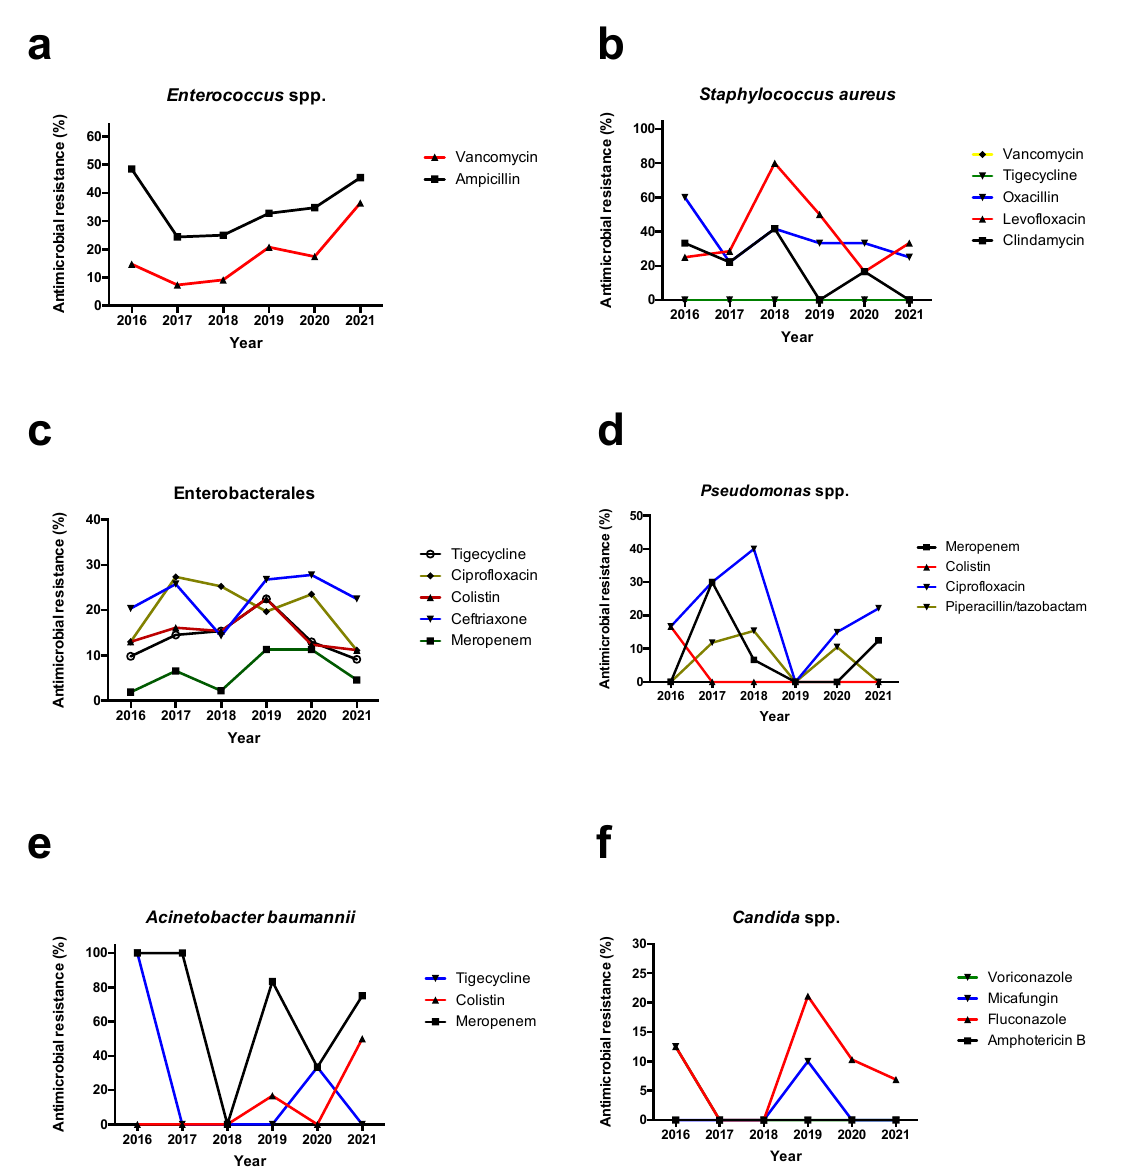
Figure 2. Antimicrobial resistance of isolated microorganisms in regard to the year during the study period. Data shown represent antimicrobial resistance of ( a ) Enterococcus spp., ( b ) Staphylococcus aureus , ( c ) Enterobacterales, ( d ) Pseudomonas spp., ( e ) Acinetobacter spp., and ( f ) Candida spp. Regarding Acinetobacter spp. (all isolates were A. baumannii ), only 16 strains were isolated.